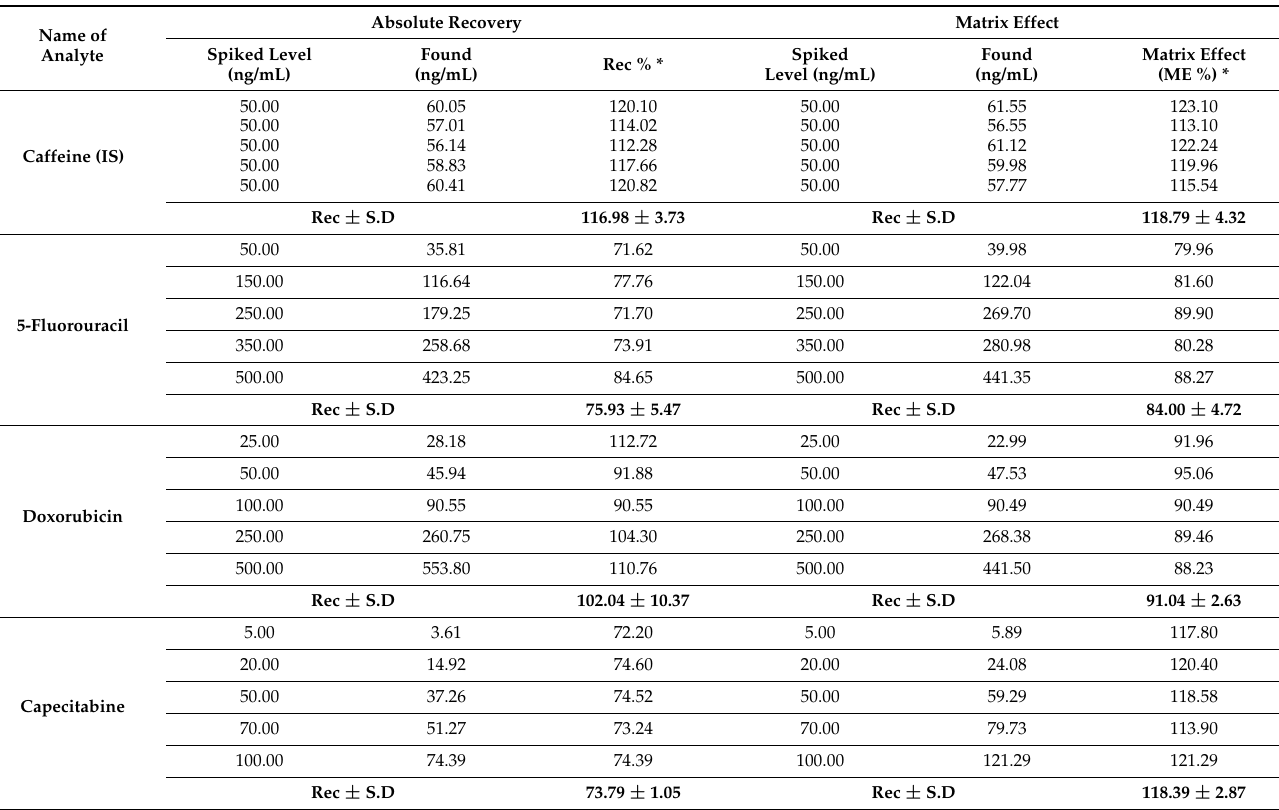
Table 3. Absolute recovery and matrix effect at five different concentration levels for the studied analytes in rat plasma using UPLC-MS/MS, ( n = 15).